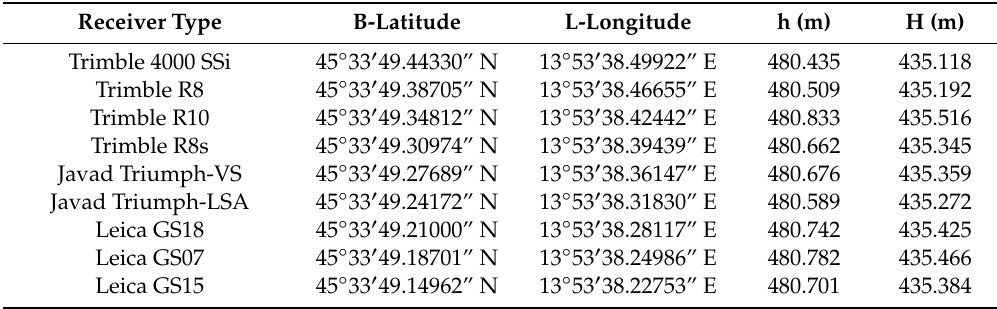
Table 1. Locations of instruments at location B in the Slovenian realisation of the coordinate system ETRS89; instruments were set up in a line. Heights H were acquired from the ellipsoidal heights h by using the SLO_VRP2016 / Koper geoid model.